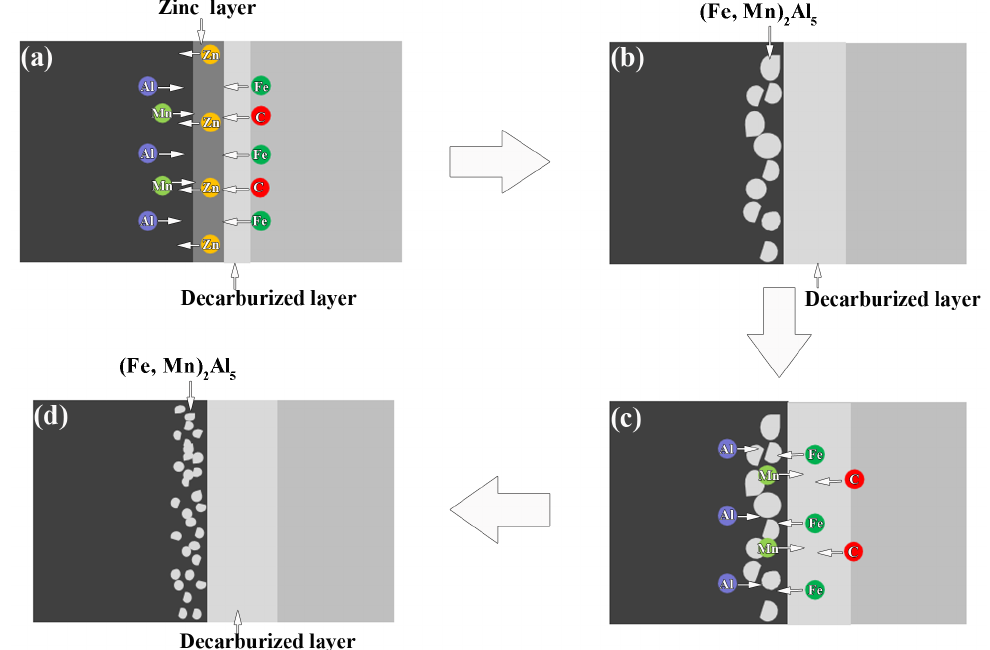
Figure 9. Schematic illustrations of reaction mechanism for AZ63 and Q235 interfaces. ( a ) The cast- ing cooling process, ( b ) After cooling, ( c ) T6 heat treatment process, and ( d ) After T6 heat treatment.